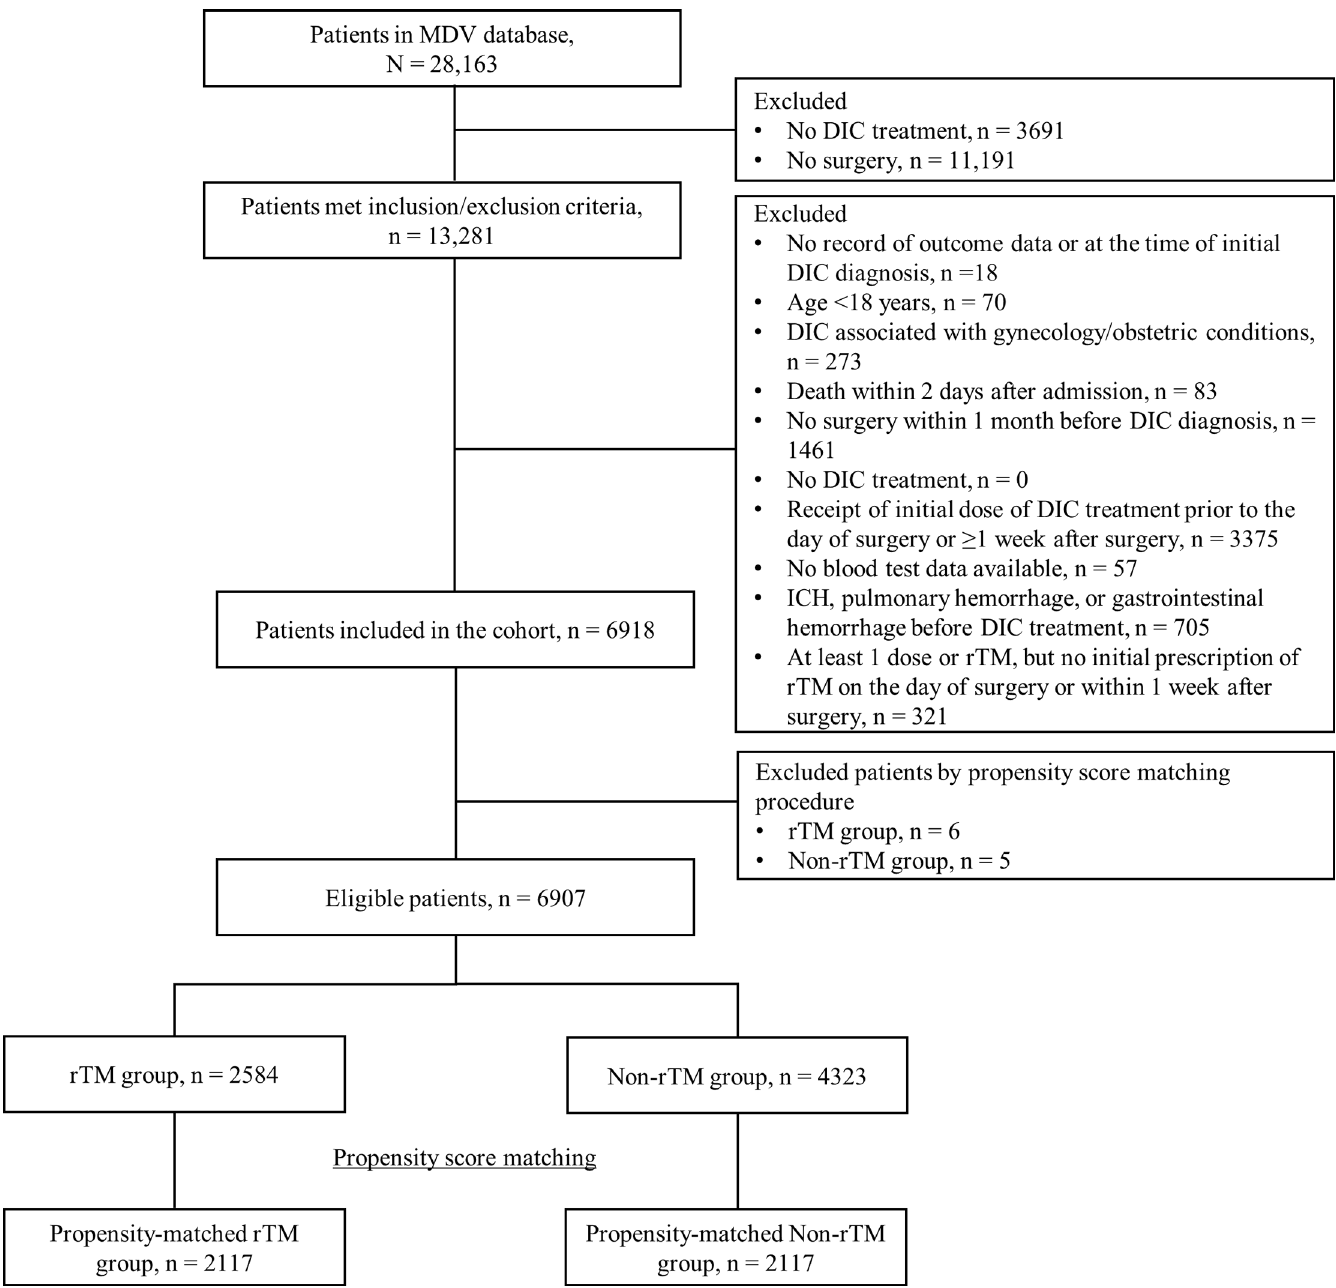
Fig 1. Flow diagram illustrating patient enrollment (all types of surgery). MDV, Medical Datavision; DIC, disseminated intravascular coagulation; rTM, recombinant thrombomodulin; ICH, intracranial hemorrhage. https://doi.org/10.1371/journal.pone.0205146.g001 The mean (± SD) age was 74.1 ± 12.8 years in the rTM group and 72.3 ± 13.2 years in the non-rTM group before matching (standardized difference = 13.6%), and 73.8 ± 13.0 years in the rTM group and 74.1 ± 13.0 years in the non-rTM group (standardized difference = 2.5%) after matching. Of the enrolled patients, 52.1% (n = 1350) in the rTM group and 59.8% (n = 2589) in the non-rTM group were males before matching. After matching, the proportion